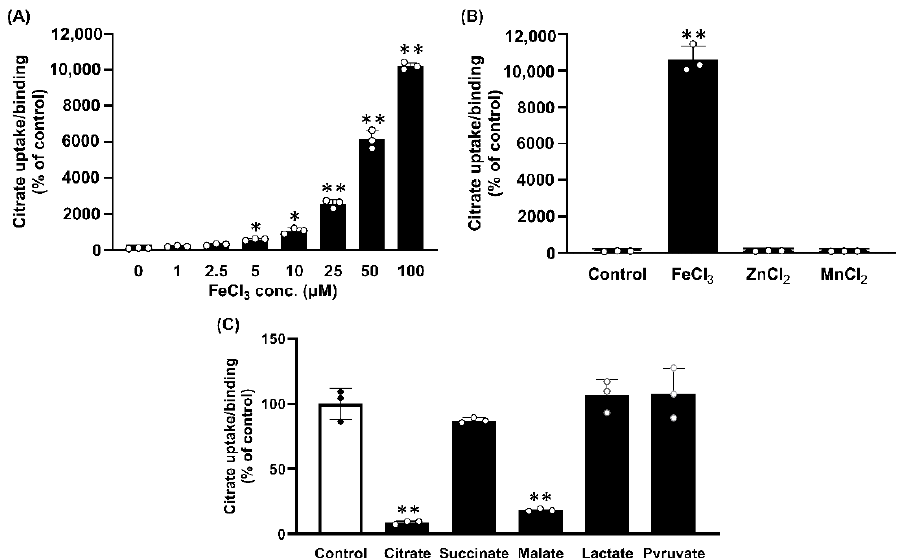
Figure 2. ( A ) Dose-response for the stimulation of citrate uptake/binding by Fe 3+ in MCF7 cells. Cells were cultured to confluence and then used for measurements of [ 14 C]-citrate (3.5 µ M) uptake/binding (NaCl buffer, pH 7.5; 15 min incubation) in the presence of increasing concentrations of Fe 3+ (FeCl 3 ). ( B ) Effects of Zn 2+ and Mn 2+ on citrate uptake/binding in MCF7 cells in the presence of Na + . Cells were cultured to confluence and then used to measure [ 14 C]-citrate (3.5 µ M) uptake/binding (NaCl buffer, pH 7.5; 15 min incubation) in the absence (control) or presence of ZnCl 2 (50 µ M) or MnCl 2 (50 µ M); FeCl 3 (50 µ M) for comparison. ( C ) Substrate selectivity for Fe 3+ -stimulatable citrate uptake/binding in MCF7 cells. Cells were cultured to confluence prior to uptake/binding measurements. Uptake/binding of [ 14 C]-citrate (3.5 µ M) uptake/binding (NaCl buffer, pH 7.5; 15 min incubation) was measured in the presence of FeCl 3 (50 µ M) in the absence or presence of the various carboxylates (2.5 mM). *, p < 0.05; **, p <